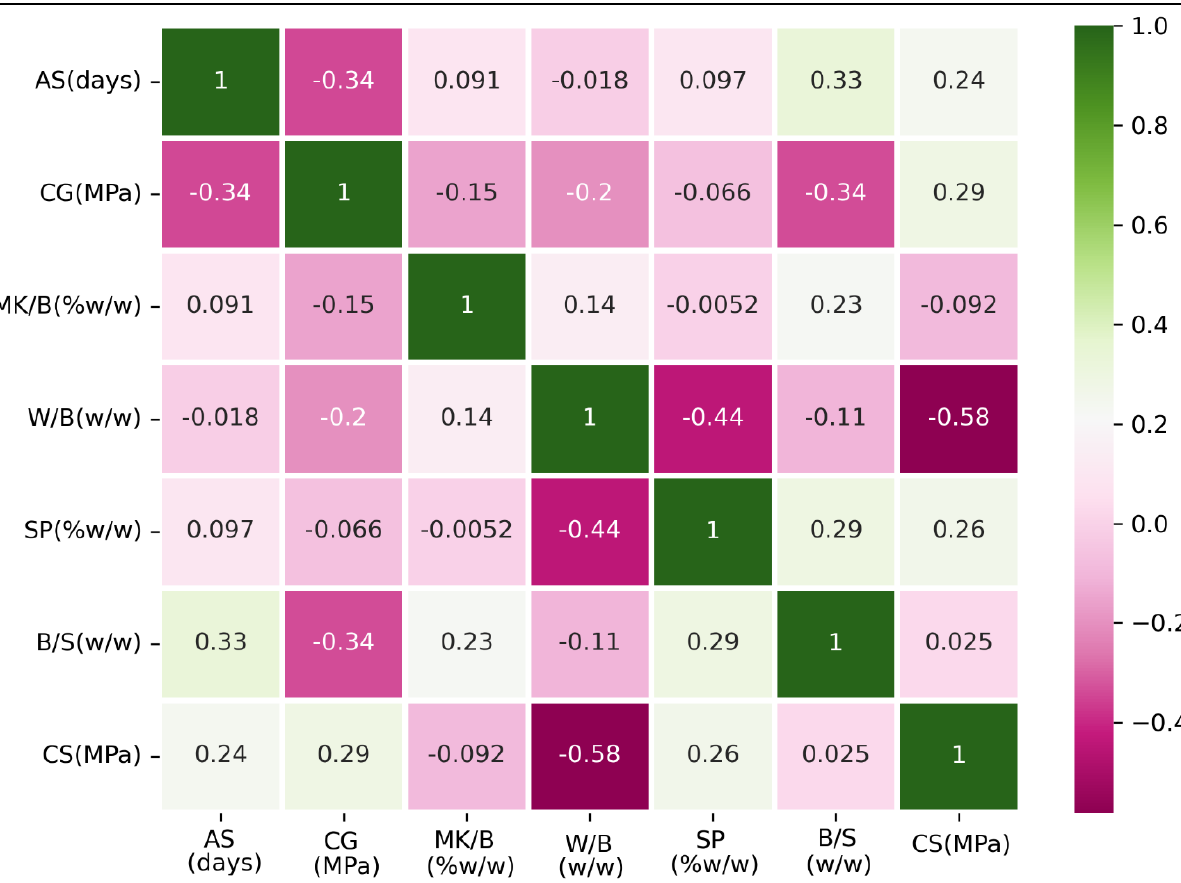
Figure 2. Correlation heatmap of input parameters and observed responses.